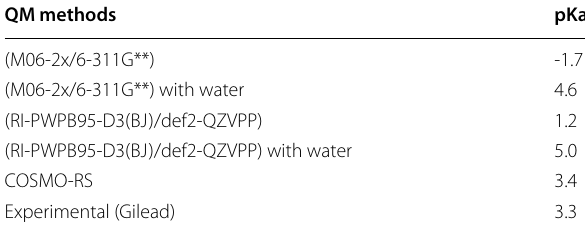
Table 6 QM‑based pKa values for Cation A QM